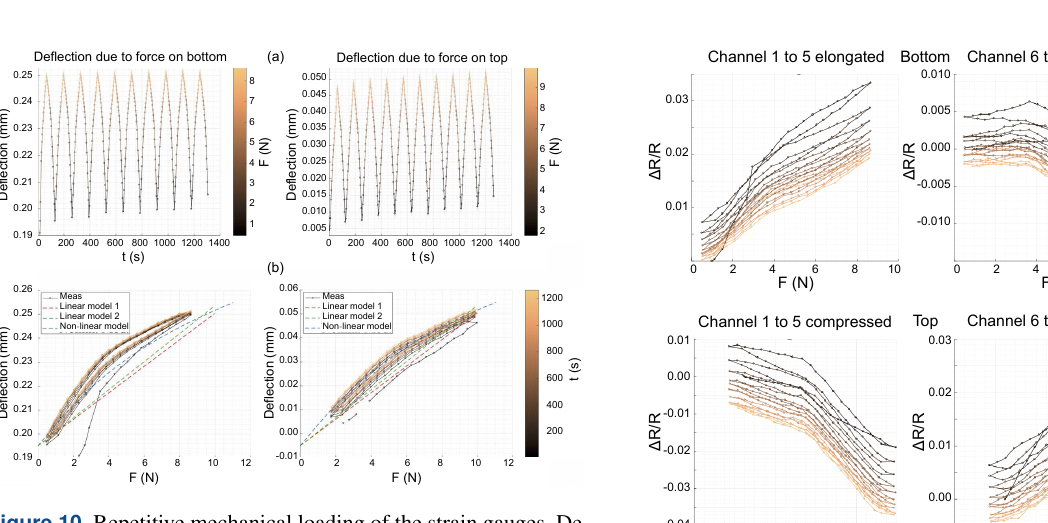
Figure 10. Repetitive mechanical loading of the strain gauges. De- flection versus time with colour coding for the load (a) and deflec- tion versus load with colour-coded time (b) (Welleweerd, 2017).